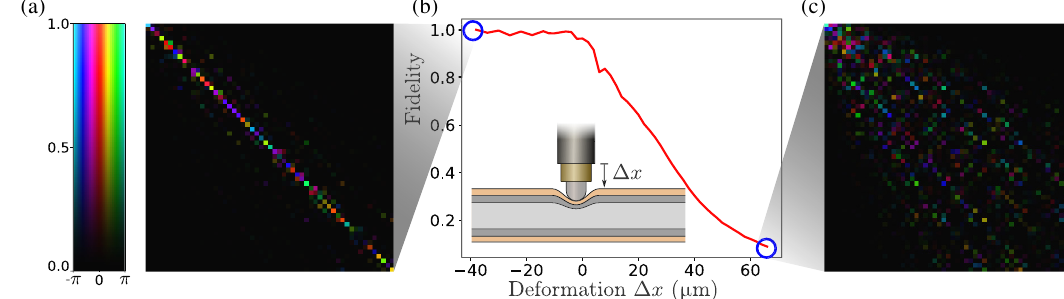
FIG. 2. Effect of deformations on the mode basis TM. (a),(c) Representation of H deformation Δ x ¼ 70 μ m is applied on the fiber. (b) Fidelity between the TM of the deformed fiber and the unperturbed one as a function of Δ x . The fidelity is defined as F inset, we represent a sketch of the deformation